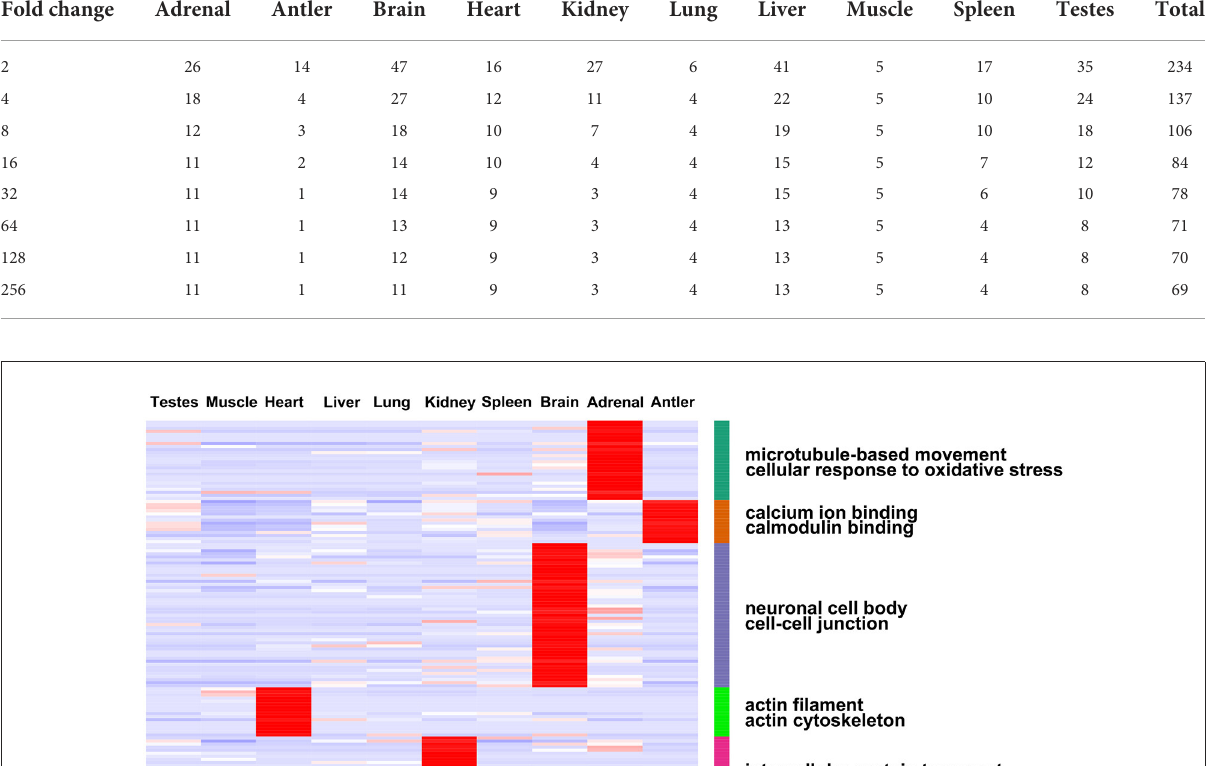
sodium ion transport, transmembrane transport, microtubule- based movement, apoptotic process and regulation of